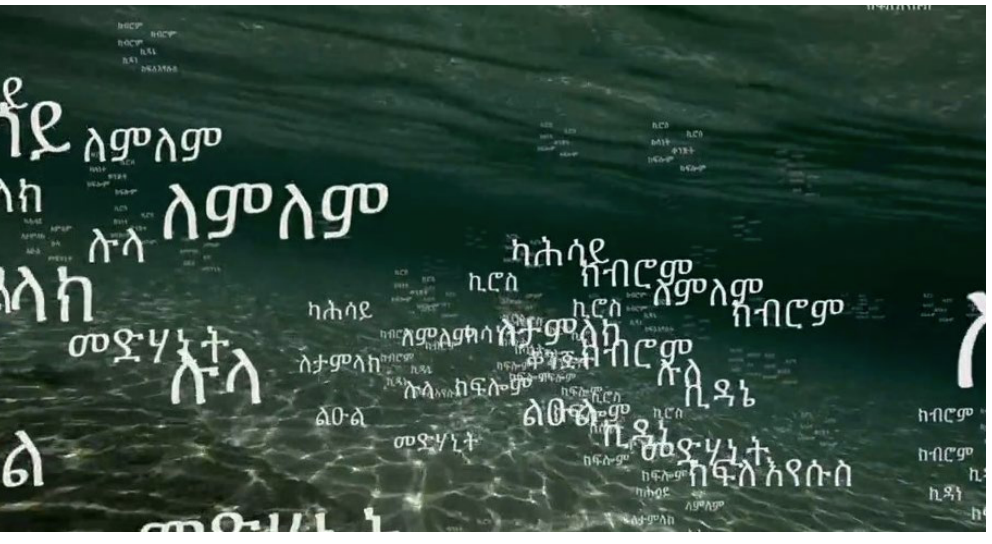
Fig. 3 Dagmawi Yimer,